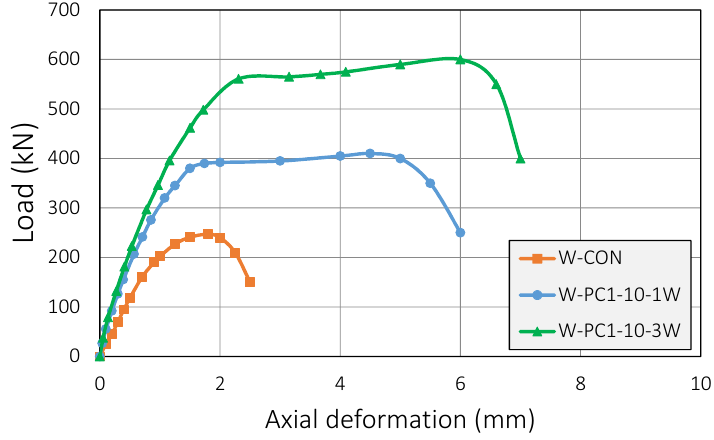
Figure 15. Experimental responses (Control and PC1 walls with wire mesh).